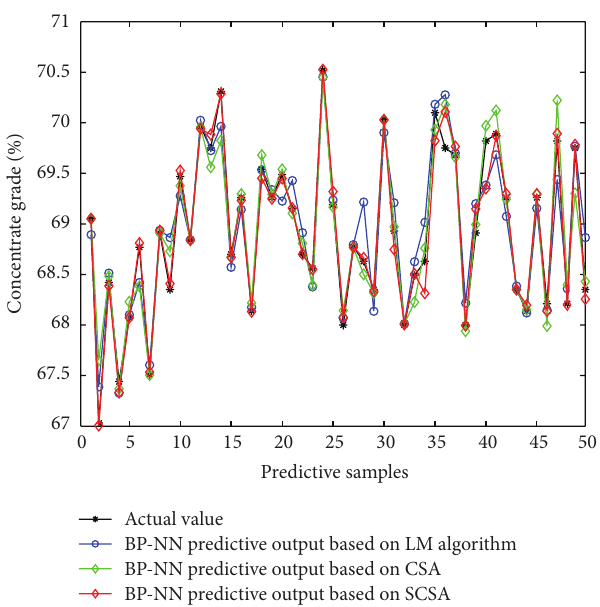
Figure 12: Predictive results of soft-sensor model.